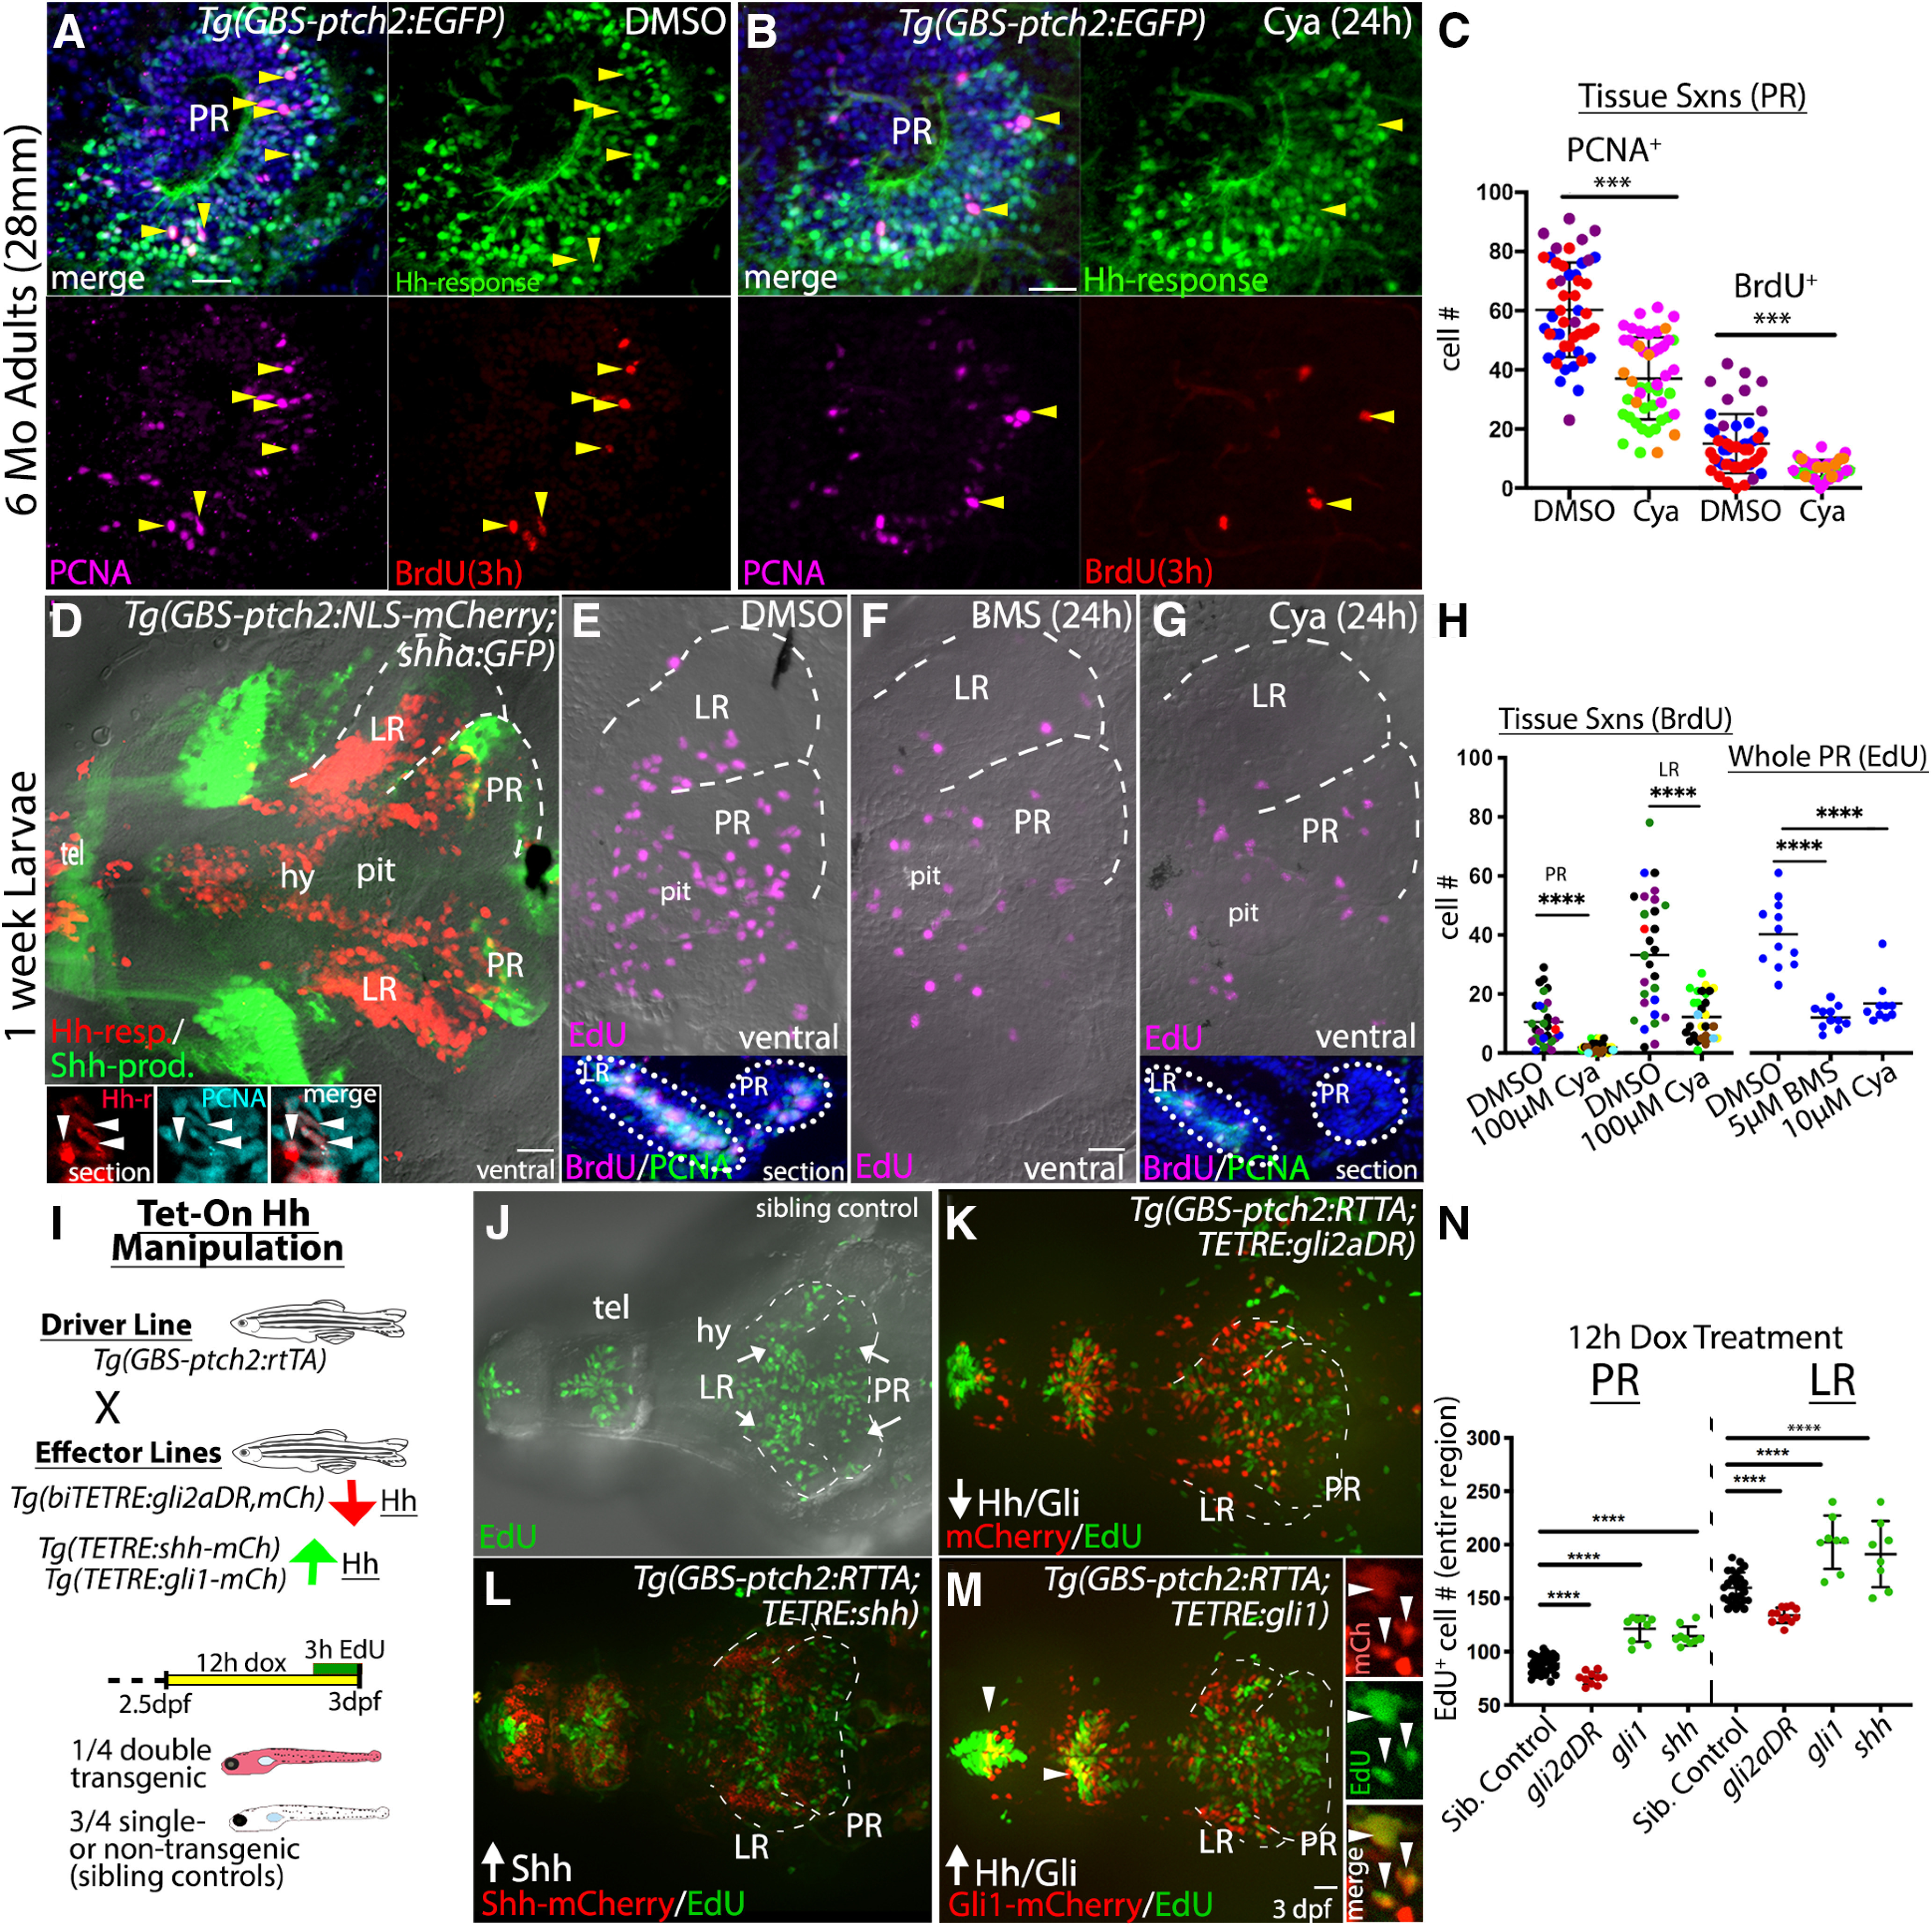
Hh signaling positively regulates proliferation in the adult and larval hypothalamus. A, Sagittal section through the PR of a DMSO (control)-injected Tg(GBS-ptch2:EGFP) transgenic adult brain showing anti-PCNA (magenta)-labeled and BrdU (red, 3-h exposure)-labeled proliferative cells. Arrowheads mark triple-labeled, proliferative, Hh-responsive cells. B, Sagittal section through the PR of a Tg(GBS-ptch2:EGFP) transgenic adult brain 24 h after injection of the Hh/Smo inhibitor Cya (80 μm) showing anti-PCNA (magenta)-labeled and BrdU (red)-labeled proliferative cells. Arrowheads mark triple-labeled cells. C, Quantification of BrdU-labeled and PCNA-labeled cells in control and Cya-injected adults. Each dot represents the number of cells counted in a single tissue section, with each color representing a different adult fish (n = 3 fish, 10–11 sections per fish). D, Ventral view of a dissected Tg(GBS-ptch2:NLS-mCherry;shha:GFP) double transgenic larval brain showing Hh-responsive (red) and Shh-producing (green) cells. The hypothalamic lobes surrounding the PR and LR of the third ventricle are outlined on one side of the brain. Insets show PCNA-labeled (cyan) Hh-responsive cells (red) in sagittal sections through the PR of a different larval brain, with examples of double-labeled cells marked by arrowheads. E–G, Ventral views of 7-dpf larval brains from fish labeled for 3 h with EdU following incubation in DMSO (control, E), BMS-833923 (BMS, F), or Cya (G) for 24 h. Insets in E, G show representative sagittal tissue sections through the hypothalamus of DMSO (E)-treated and Cya (F)-treated larvae labeled to show BrdU (2-h treatment) and PCNA-labeled proliferative cells. H, Quantification of EdU-labeled, BrdU-labeled, and PCNA-labeled cells in the PR and LR. For tissue sections (left), each color represents a different larval fish (n = 5 controls, n = 6 Cya treated), and each dot represents cells in a single tissue section (five to nine sections per fish). For whole PR EdU counts (right), each dot represents one larva (n = 12 for DMSO, 11 for BMS, and 10 for Cya). I, Schematic showing the Tet-On transgenic system used to manipulate Hh signaling. The Tg(GBS-ptch2:RTTA) line drives expression of the RTTA transcriptional activator in Hh-responsive cells, with different effector transgenes allowing upregulation and downregulation of Hh signaling on the addition of doxycycline, which is required for RTTA function. Activation of the two-part transgenic expression system is indicated by mCherry fluorescence in larvae, as shown in the diagram of the experimental timeline. J–M, Ventral views of EdU-labeled (3-h exposure) proliferative cells in the larval hypothalamus following manipulation of Hh signaling levels using the Tet-On system. J, EdU-labeled proliferative cells (green) in a single-transgenic sibling (control), identified based on the lack of red fluorescence. K, EdU-labeled proliferative cells (green) visualized 12 h after activation of a dominant repressor form of the Gli2 transcription factor (Gli2DR) in Hh-responsive cells (red). L, EdU-labeled proliferative cells (green) visualized following activation of the Shh effector transgene [Tg(TETRE:shha-mCherry)] in Hh-responsive cells [Tg(GBS-ptch2:RTTA) driver]. M, EdU-labeled proliferative cells 12 h after activation of the Gli1-mCherry fusion protein in Hh-responsive cells (red). A subset of EdU-labeled cells was co-labeled with the mCherry protein (arrowheads). Separated EdU, mCherry, and merged channels from the PR of a different brain are shown on the right. N, Quantification of all EdU+ proliferating cells in the PR and LR of the larval hypothalamus following Hh-manipulation using the Tet-On system. Each dot represents an individual fish. Upregulation of Hh/Gli signaling via the shha and gli1 transgenes led to increased proliferation, while downregulation of Hh signaling via the gli2DR transgene reduced proliferation; ***p < 0.001, ****p < 0.0001. Source data for graphs can be found in Extended Data Figure 3-1. Scale bars: 20 μm.